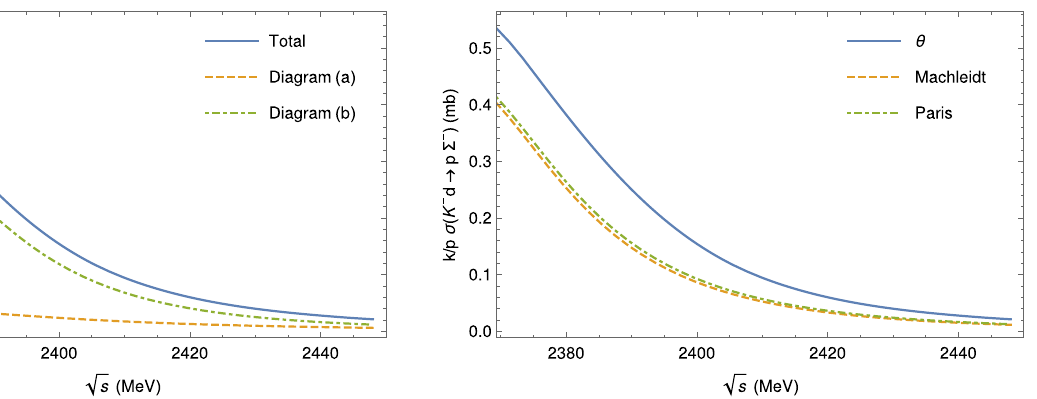
Fig. 7 Contributionsofthehighandlowmasspoles(left)anddiagrams a and b (right), compared to the total k pole in Fig. 6 (left) is due to the fact that g 2